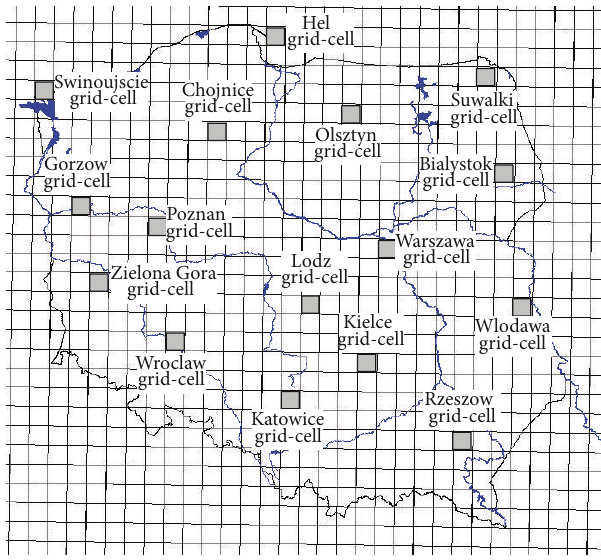
Figure1:Thestudiedgrid-cells(grid-cellcontainingthetowns/cities over